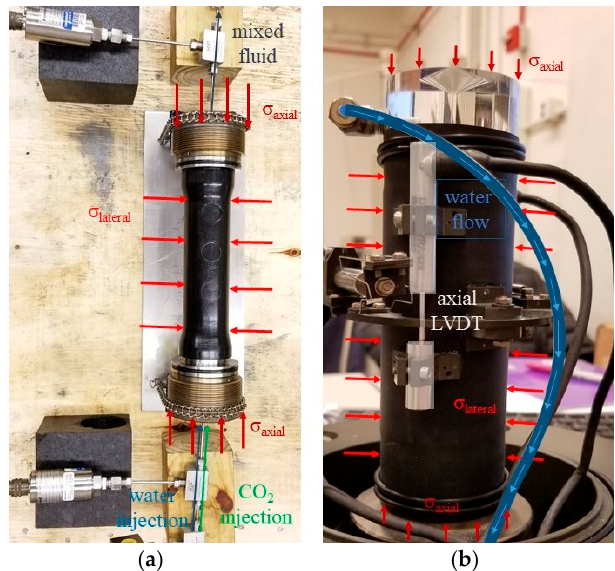
Figure 3. Experimental setup: ( a ) core flooding device for CO 2 treatment and permeability measurements on cylindrical (50 mm in diameter and 100 mm long) specimens and ( b ) cylindrical specimen (50 × 100 mm) with instrumented Linear Variable Differential Transformers (LVDTs) and pore pressure lines that is tested in 3.5 MPa GDS triaxial cell.